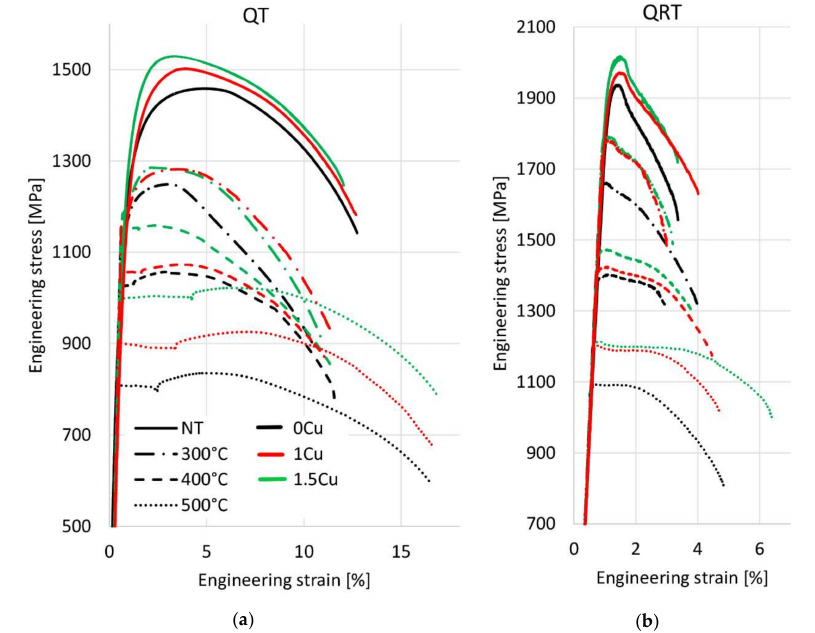
Figure 3. Engineering stress–strain diagrams of samples of 0Cu, 1Cu, and 1.5Cu materials: ( a ) quenched and tempered samples (60 min); ( b ) quenched, rolled, and tempered samples (60